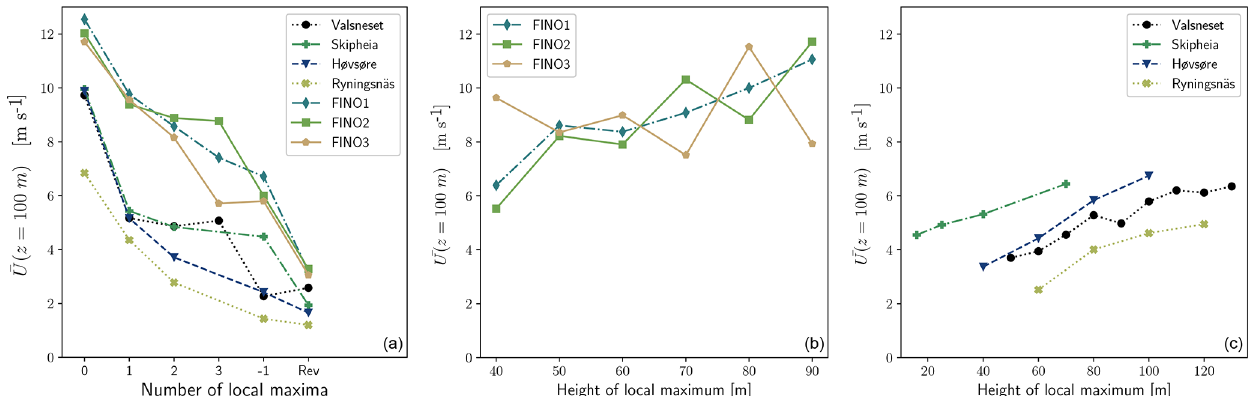
Figure 7. (a) Mean wind speed at z = 100m of different profile categories. (b) Mean wind speed at z = 100m for offshore sites, with VWP maxima at different heights. (c) Mean wind speed at z = 100m for onshore sites with VWP maxima at different heights. Similar results were found when using the lowest wind speed measurement height at each site.